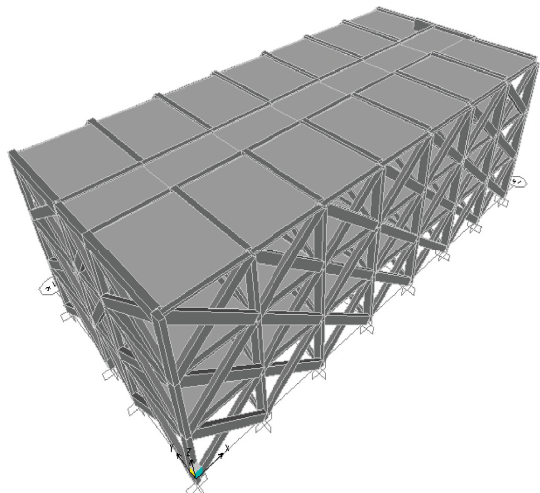
Figure 1: The representation infills the frame with bracing in three dimensions.